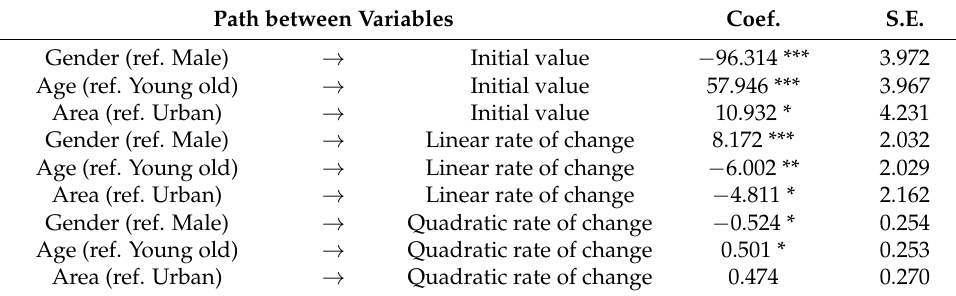
Table 4. Path Coefficient of Study Model. Path between Variables Coef. S.E. Gender (ref.